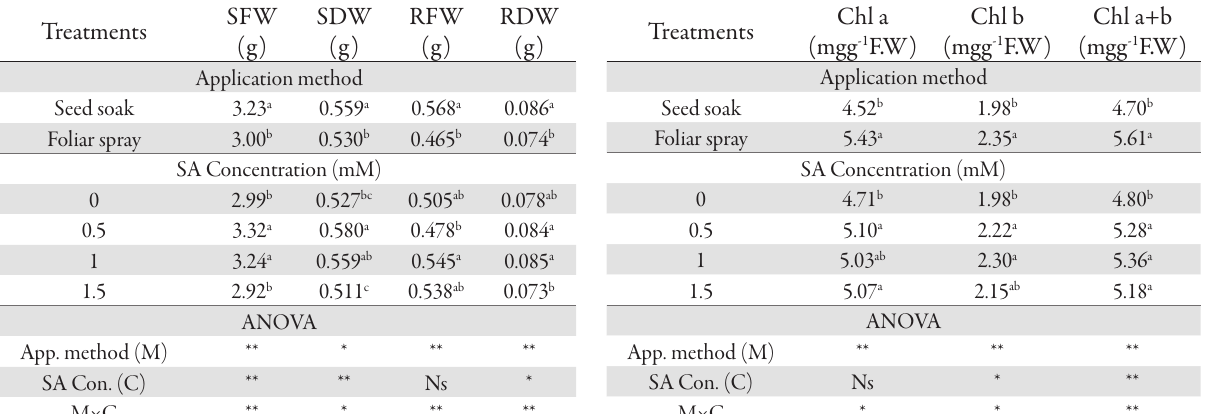
Tab. 2. Effect of SA and its application method on